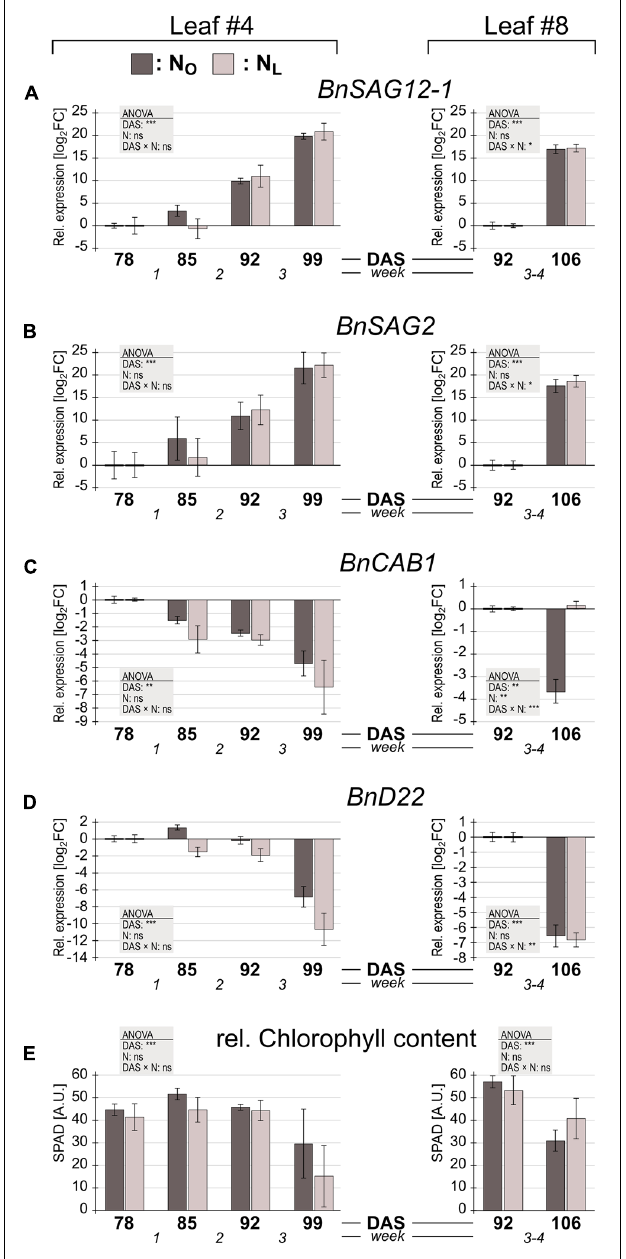
FIGURE 2 | Senescence marker gene expression and chlorophyll content in Brassica napus leaves of plants grown under optimal or reduced N supply. B. napus leaves #4 and #8 of plants grown under optimal N supply (N O ; dark gray columns) or under reduced N supply (N L ; light gray columns) were harvested at the indicated days after sowing (DAS). Relative expression levels were determined by qPCR. For leaf #4, expression changes relative to the level at 78 DAS, and for leaf #8, expression changes relative to the level at 92 DAS are shown of (A) senescence associated gene BnSAG12-1 , (B) senescence associated gene BnSAG2 , (C) chlorophyll a/b binding protein gene BnCAB1 and (D) B. napus gene BnD22 . (E) Relative chlorophyll contents at each harvest time point are shown as SPAD values. Error bars indicate the standard error of the means ( n = 3). Significant expression differences by N treatment, over time and by interaction of the two parameters